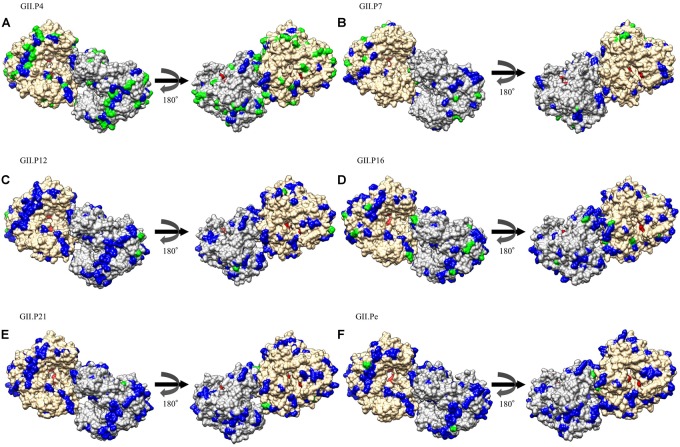
Structural models for the RdRp protein of each genotype. Three-dimensional RdRp dimer structures for GII.P4 (A), GII.P7 (B), GII.P12 (C), GII.P16 (D), GII.P21 (E), and GII.Pe (F) are shown. The chains to composing the dimer structures are colored gray (chain A) and Navajo white (chain B). Negative selection sites are colored green. Amino acid substitutions of the other genotypes compared to the GII.P8 strain are colored blue. Active site residues are colored red.